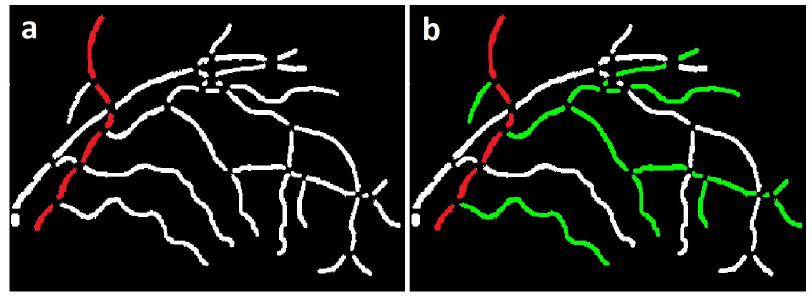
Figure 6. Image example: a) Vessel segment map showing the true vessel path b) True vessel path with branches. doi:10.1371/journal.pone.0088061.g006 PLOS ONE |